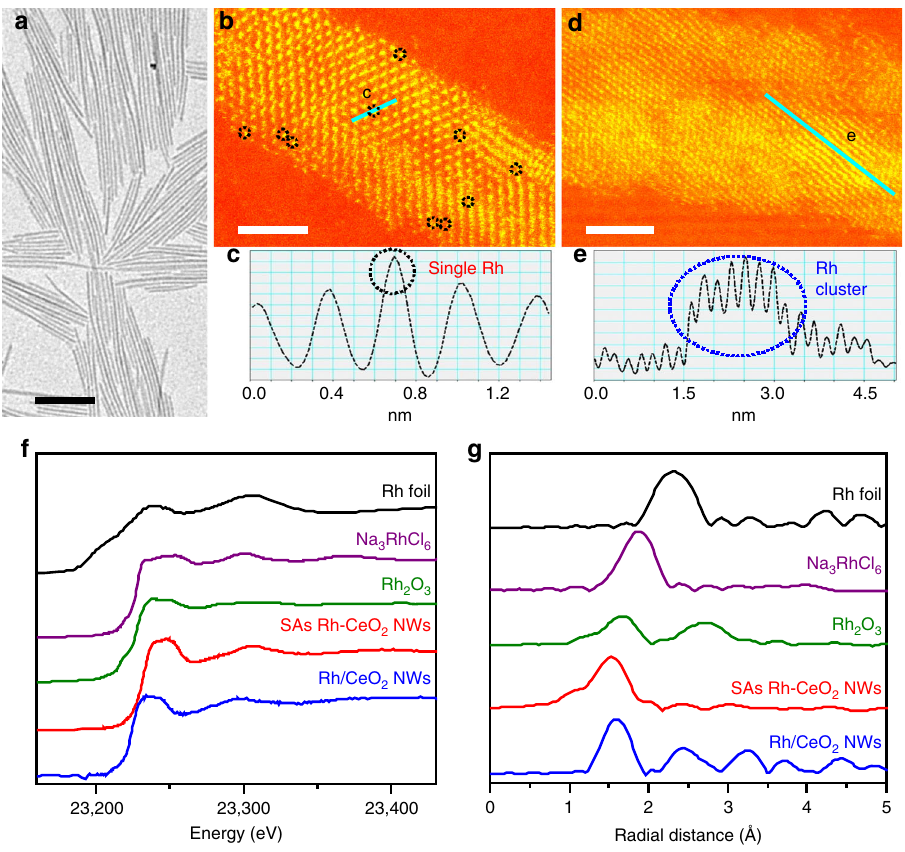
Fig. 1 Structural analyses of SAs Rh-CeO 2 NWs and Rh/CeO 2 NWs. a TEM image of the SAs Rh-CeO 2 NWs. b AC-HAADF/STEM image in temperature color of the SAs Rh-CeO 2 NWs. The isolated Rh atoms are marked with black circles. c The intensity pro fi le recorded from the line in panel ( b ). d AC- HAADF/STEM image in temperature color of the Rh/CeO 2 NWs. The Rh cluster is marked with blue line. e The intensity pro fi le recorded from the line in panel ( d ). f , g Rh K-edge XANES spectra ( f ) and Rh K-edge EXAFS spectra in R space ( g ) of the Rh foil, Na 3 RhCl 6 , Rh 2 O 3 , SAs Rh-CeO 2 NWs, and Rh/CeO 2 NWs. The scale bars in ( a ), ( b ), and ( d ) are 100, 2, and 2 nm,